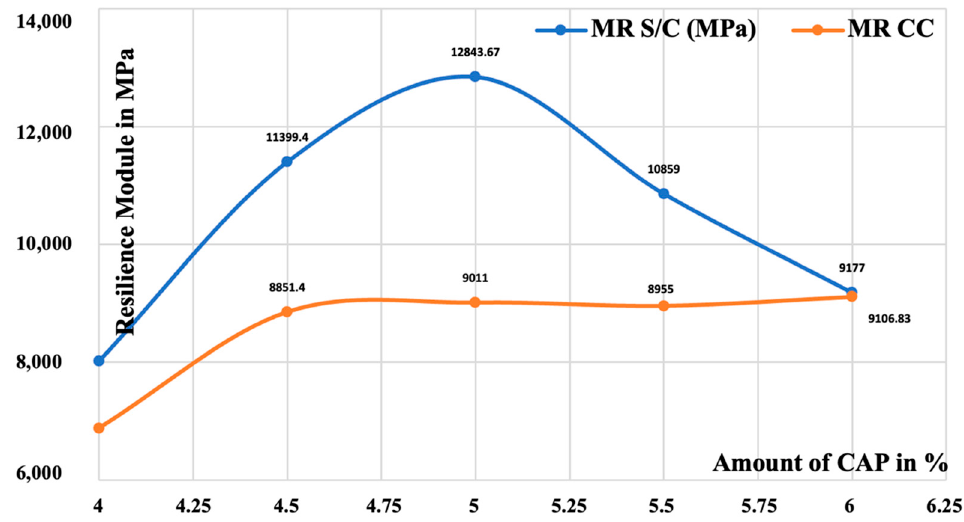
Figure 4. Resilience